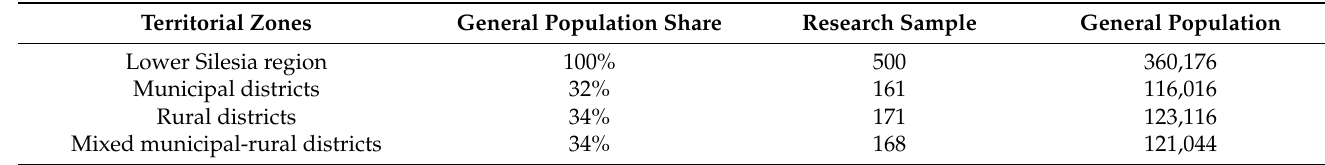
Table 1. Statistical distribution of investigated